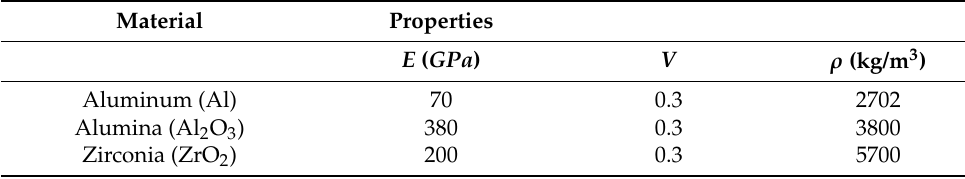
Table 1. Material properties used in the FG plates